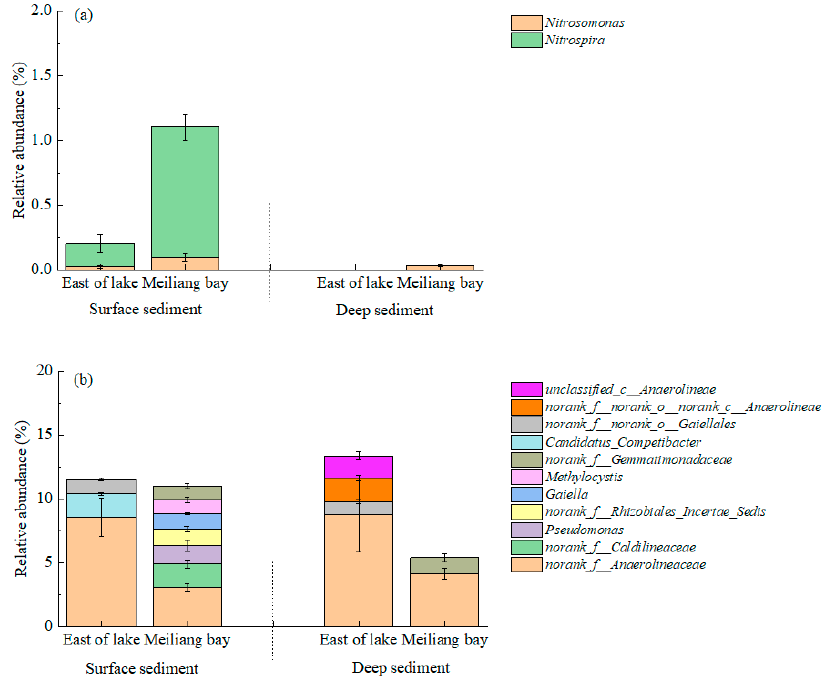
Figure 7. Typical bacteria participating in N transformation in the sediments at the genus level. ( a ) shows nitrifying bacteria; ( b ) shows denitrifying bacteria.